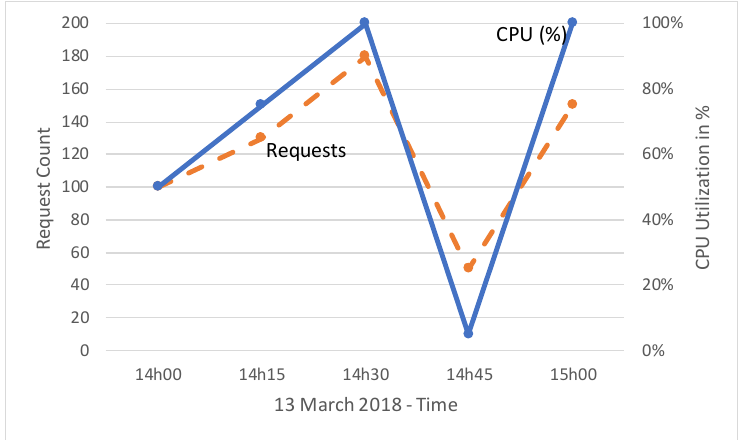
Figure 6. Worst-case transaction scenario, with IBM Internet of Things (IoT) central processing unit based on primary axis the numbers of the arrived transaction request (dashed line) and (CPU) utilization (solid line) on secondary axis.